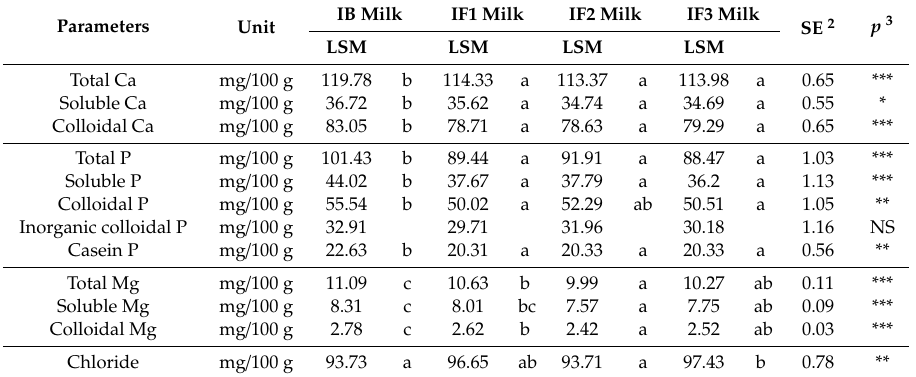
Table 2. Least square mean values of mineral content and distribution of vat milk from Italian Brown (IB milk) or Italian Friesian (IF1, IF2, IF3 milk) cattle herds used in 12 Parmigiano Reggiano cheese-making trials 1 .